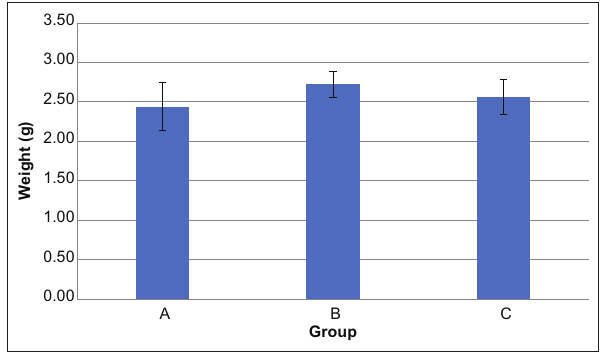
Figure-2: Average of testicle weight of rats in Group A, Group B, and Group C. Statistical analysis showed no significant difference.